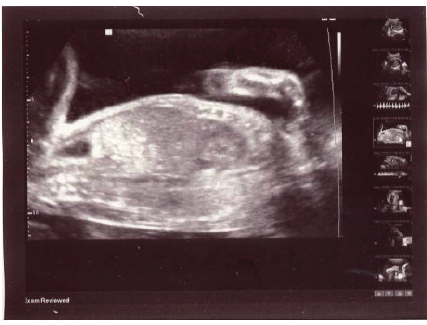
Figure 2: Echogenic bowel.